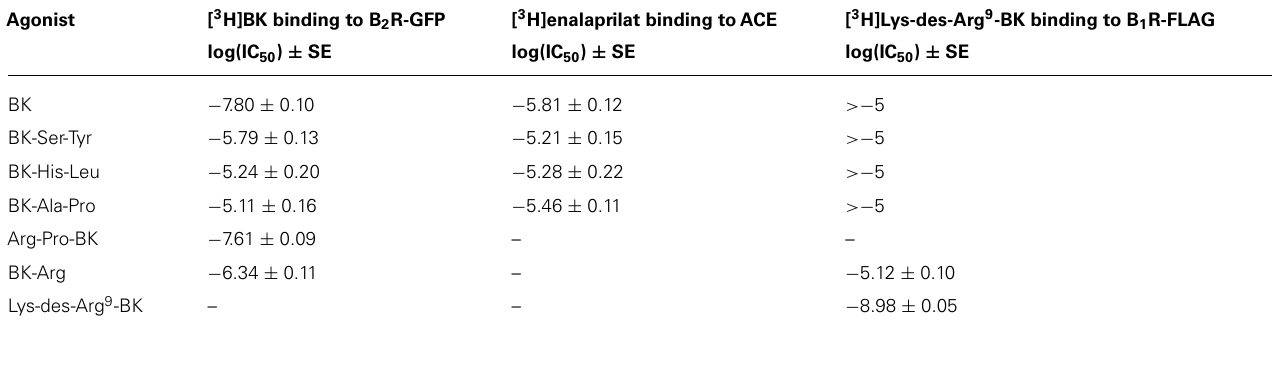
Table 1 | Parameters derived from radioligand binding competition